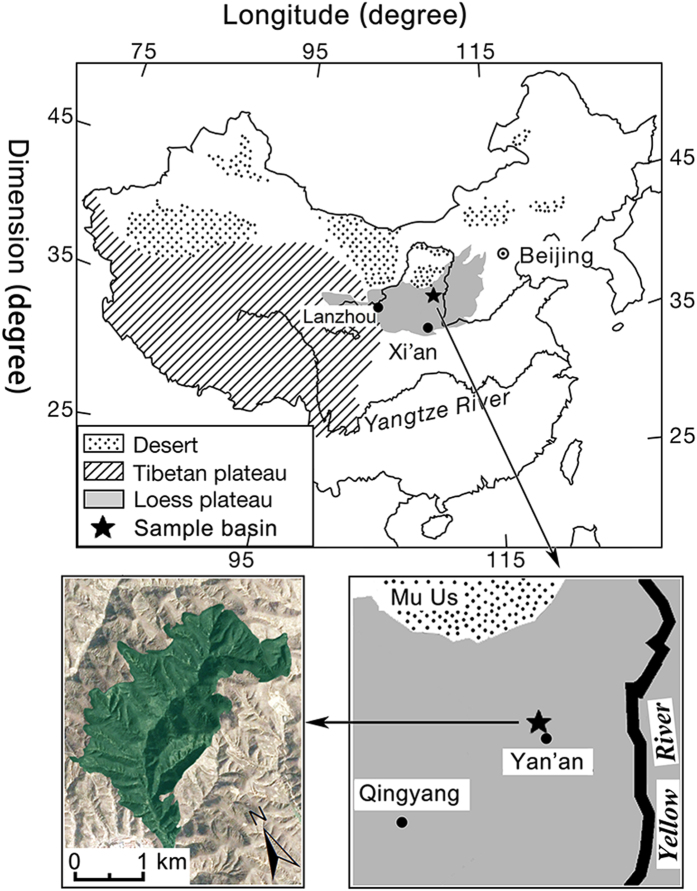
Location of the Loess Plateau and the study basin, Maps generated using ArcGIS (10.0)(http://www.esri.com/software/arcgis).